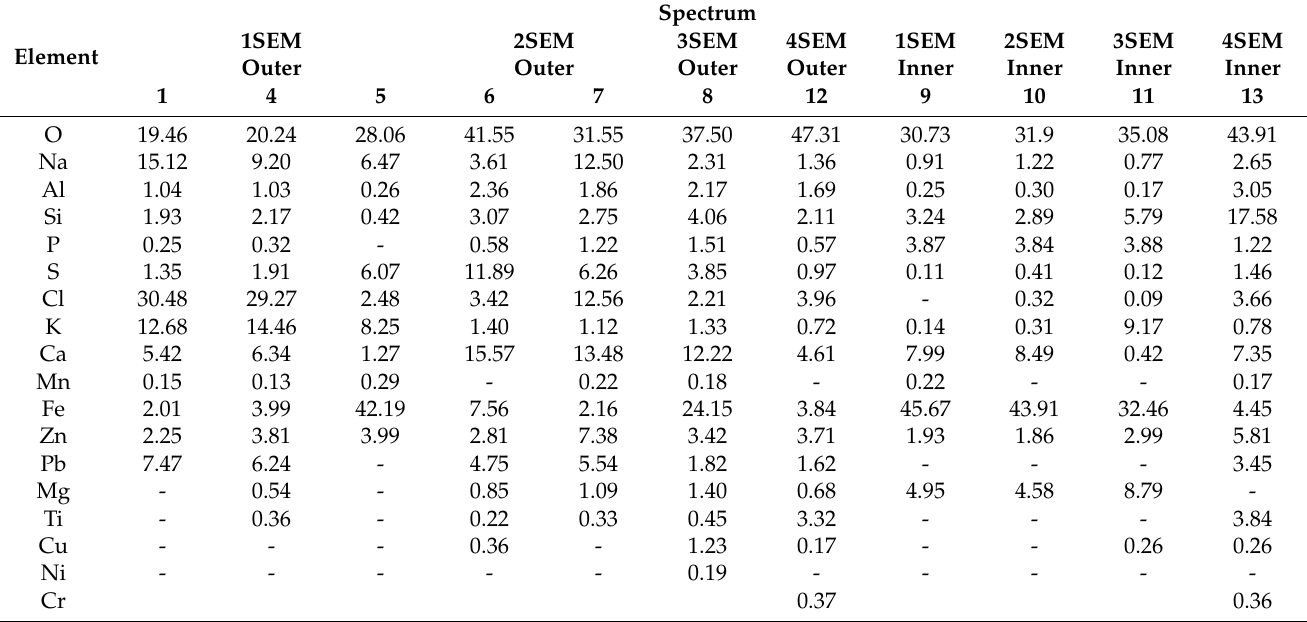
Table 4. Quantitative EDX analysis in wt